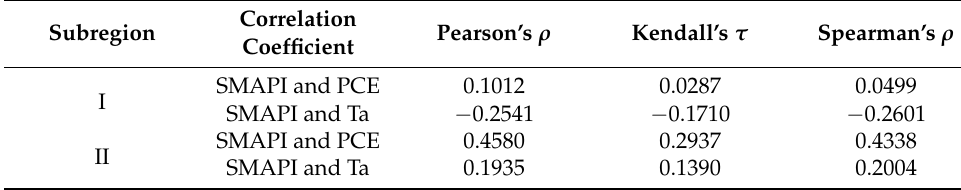
Table 3. Correlation coefficients of the SMAPI, PCE and Ta.